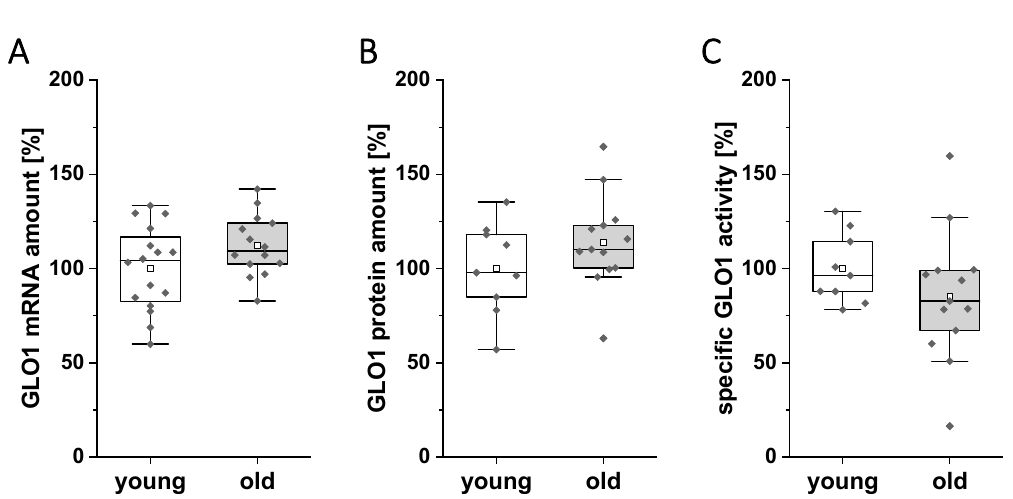
Figure 1. Quantification of GLO1 mRNA, protein and enzymatic activity in the ovary of young and old rabbits at day 6 p.c. ( A ) GLO1 mRNA levels were quantified by qPCR. ( B ) GLO1 protein was measured by the Simple Western method. Both mRNA and protein amount were normalised to the levels of vinculin. ( C ) Enzymatic GLO1 activity was measured spectrophotometrically in 10 µ g ovarian protein lysate. Specific GLO1 activity was calculated relative to GLO1 protein amount within the same sample. Results are shown as box plots. All values are expressed in per cent, with young rabbits = 100% ( n ≥ 9).